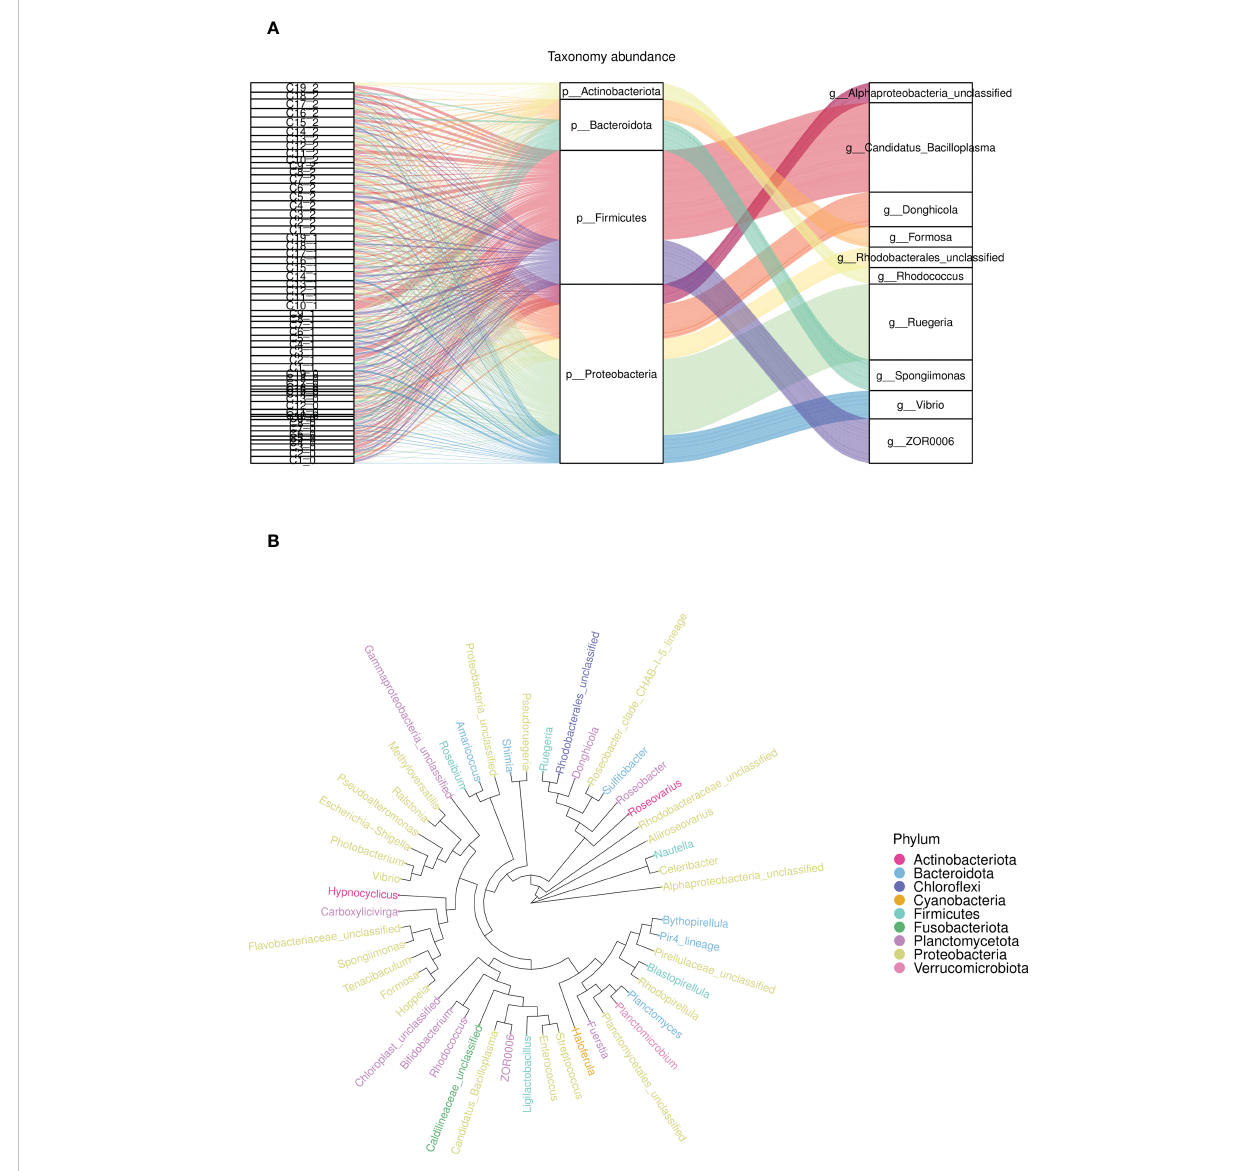
FIGURE 6 The relative abundance an phylogenetic tree of microbial community composition in the intestine. (A) The relative abundance of fl ora at phylum level (middle) and genus level (right) for different samples (left), (B) The phylogenetic tree of top 30 relative abundance species in each group at phylum